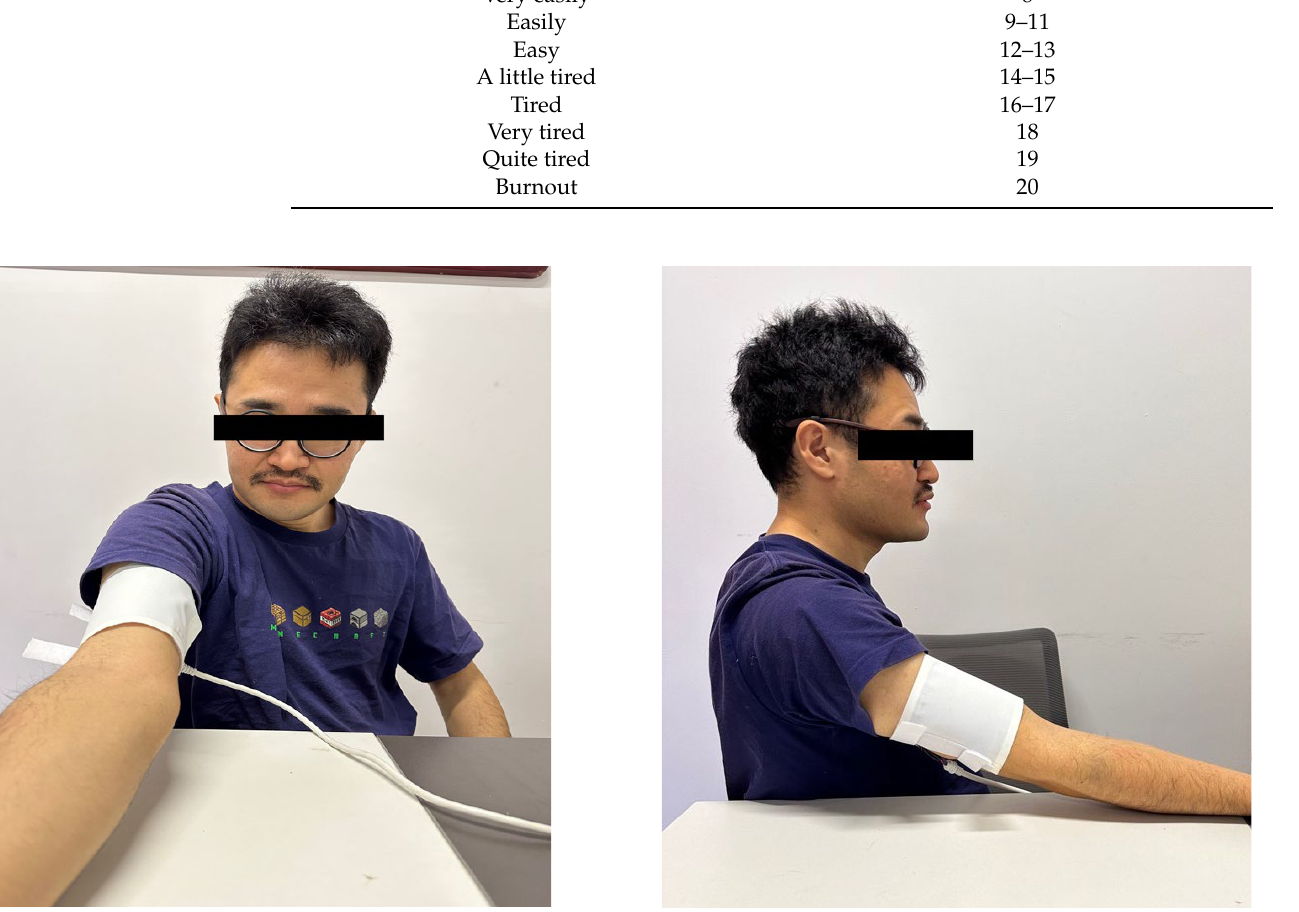
Figure 3. Wearing diagram of the FIR device.